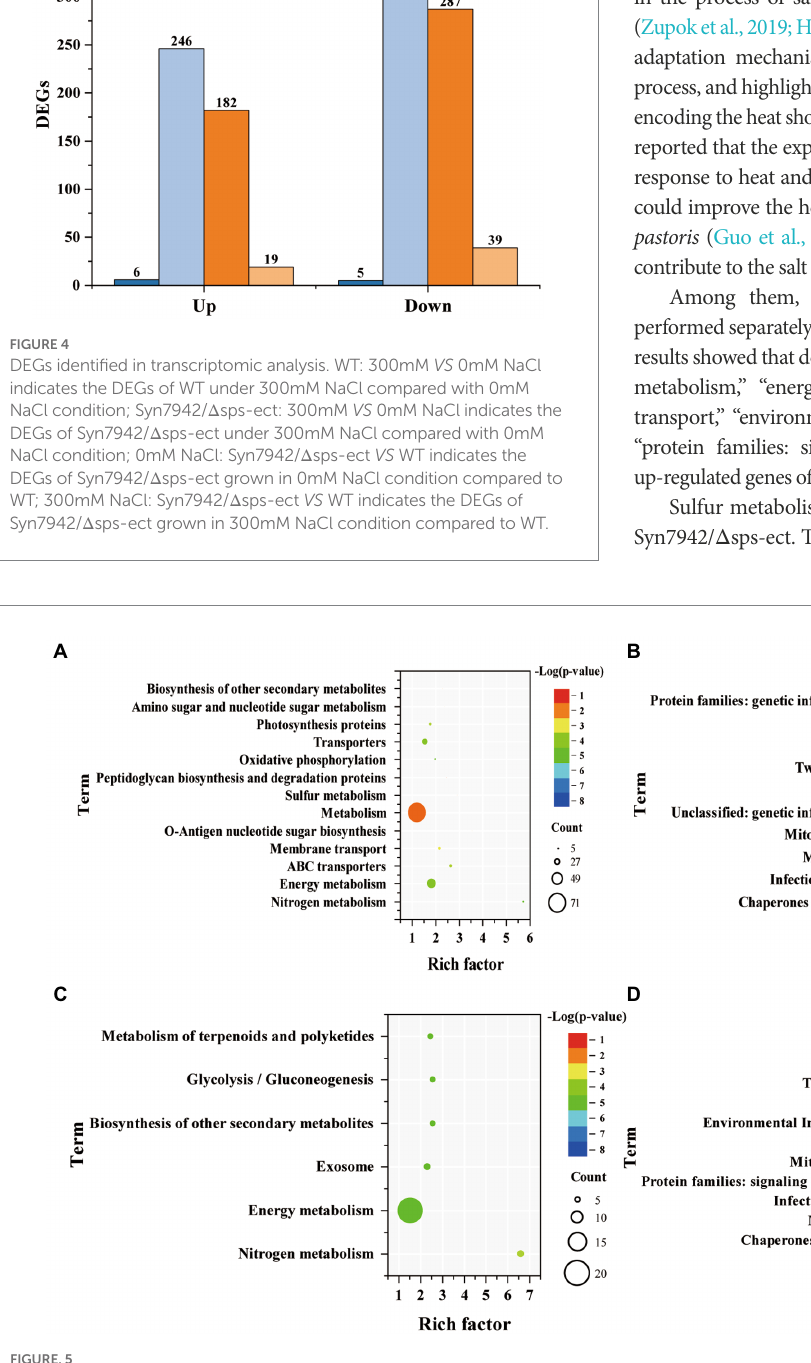
FIGURE. 5 Enriched pathway terms of DEGs in WT and Syn7942/ Δ sps-ect. (A) Enriched pathway terms based on up-regulated genes of WT; (B) Enriched pathway terms based on down-regulated genes of WT; (C) Enriched pathway terms based on up-regulated genes of Syn7942/ Δ sps-ect; (D) Enriched pathway terms based on down-regulated genes of Syn7942/ Δ sps-ect. WT: 300 mM VS 0 mM NaCl indicates the DEGs of WT under 300 mM NaCl compared with 0 mM NaCl condition; Syn7942/ Δ sps-ect: 300 mM VS 0 mM NaCl indicates the DEGs of Syn7942/ Δ sps-ect under 300 mM NaCl compared with 0 mM NaCl condition; 0 mM NaCl: Syn7942/ Δ sps-ect VS WT indicates the DEGs of Syn7942/ Δ sps-ect grown in 0 mM NaCl condition compared to WT; 300 mM NaCl: Syn7942/ Δ sps-ect VS WT indicates the DEGs of Syn7942/ Δ sps-ect grown in 300 mM NaCl condition compared to